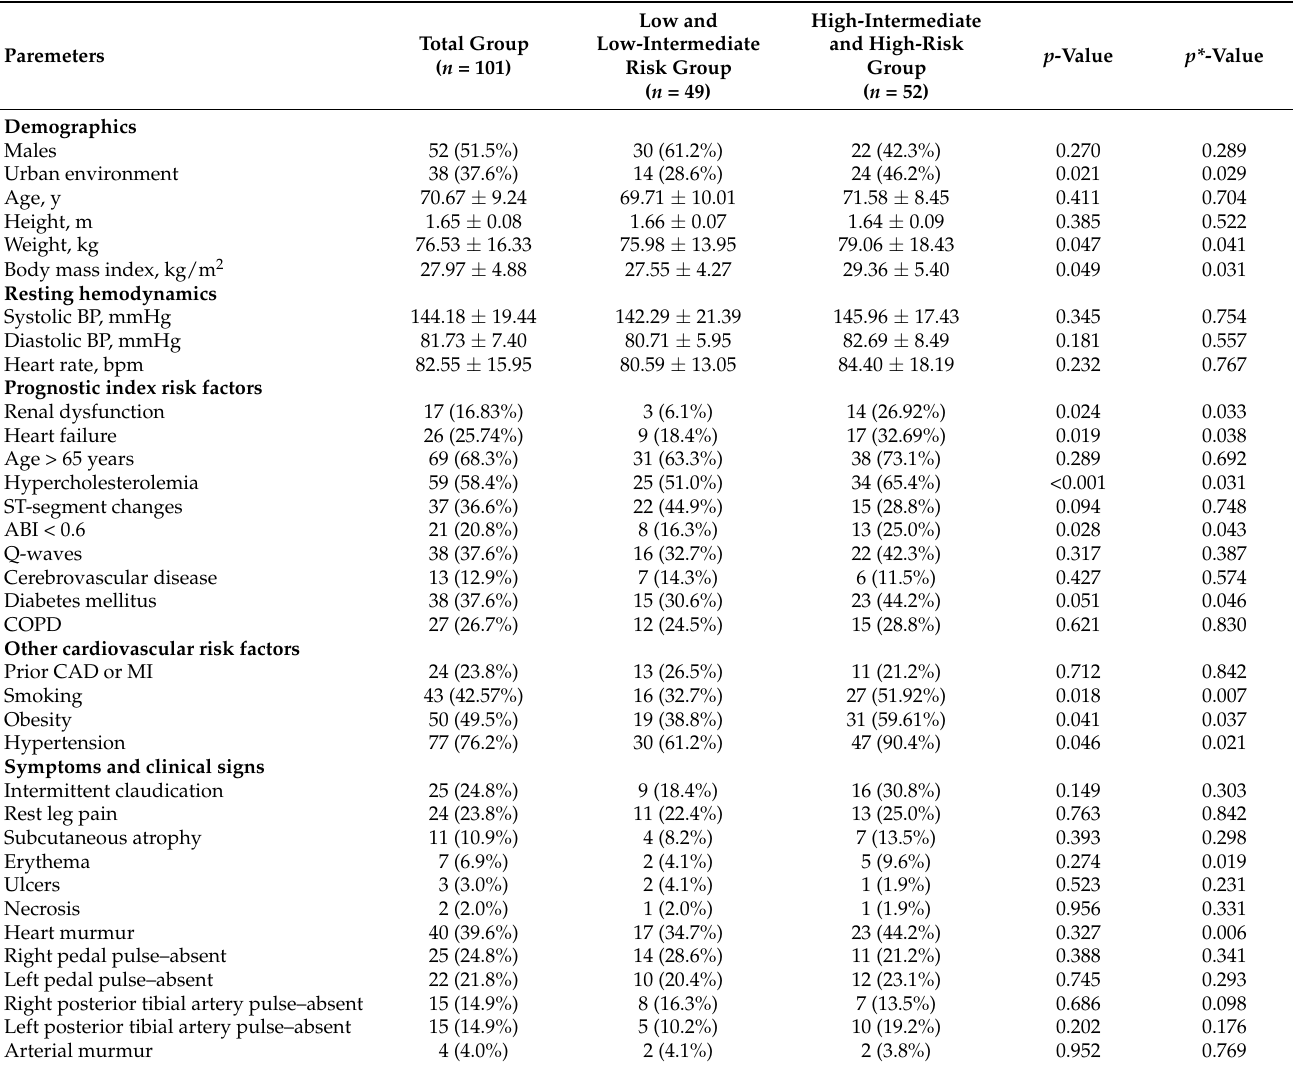
Table 1 summarizes the statistical analysis of demographic data, vital parameters, predictors of index score, and cardiovascular risk factors or parameters derived from the clinical picture. In terms of demographics, we included patients previously diagnosed with PAD with a mean age of 70.67 ± 9.24, which were mainly male (51.5%). The percentage of patients over 65 years of age was higher in the high-intermediate and high-risk mortality group (63.3% vs. 73.1%, p = 0.692). Regarding anthropometric parameters, the average BMI at enrolment was 27.97 ± 4.88 kg/m 2 with a higher mean value among high-intermediate and high-risk patients (27.55 ± 4.27 kg/m 2 vs. 29.36 ± 5.40 kg/m 2 ) and statistically significant value ( p = 0.049). Table 1. Demographics, resting hemodynamics, and risk index